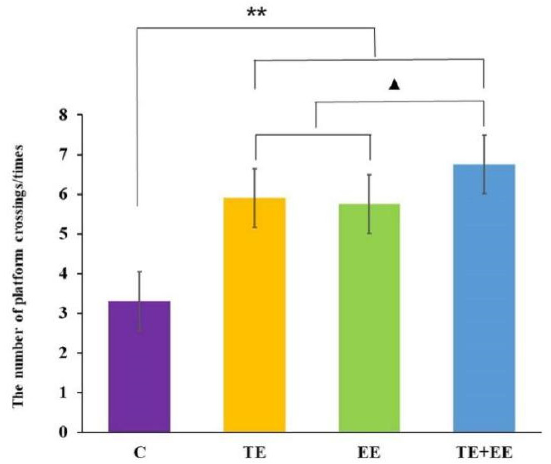
Figure 3. Average number of platform crossings in the Control (C), Treadmill Exercise (TE), Enriched Environment (EE) and Treadmill Exercise Combined with Enriched Environment (TE + EE) groups ( N = 10, x ± s ). Note: compared with the C group, ** p < 0.01; compared with TE + EE group, ▲ p < 0.05.